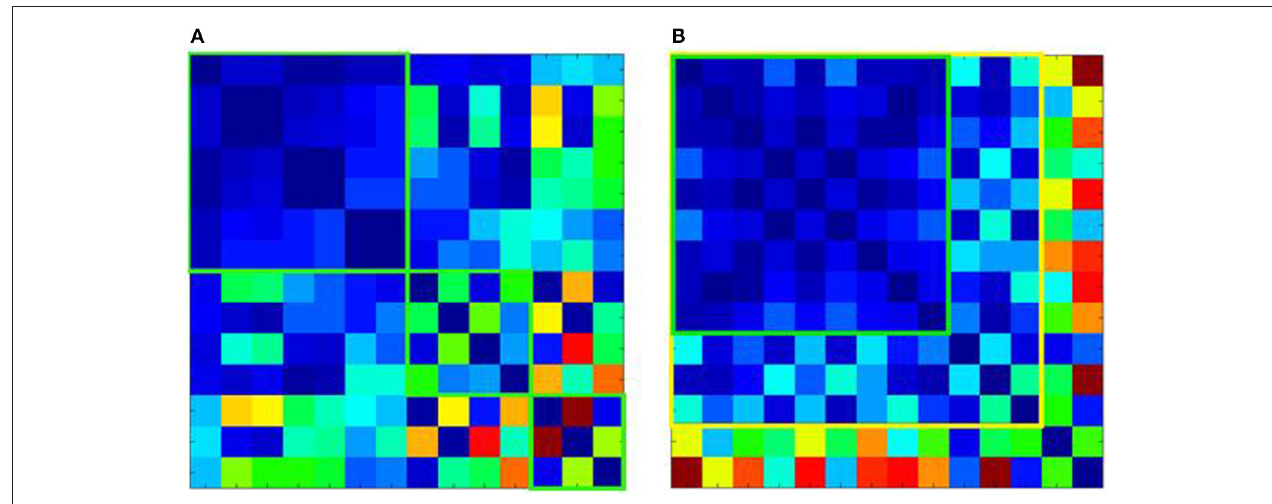
FIGURE 2 | Mahalanobis distance analysis of quality parameters for T1-weighted images of 14 ALS centers. (A) Shows the Mahalanobis distances of the raw T1 data, revealing 3 clusters of centers, which although internally homogenous (green squares) could not be pooled into one large data set. (B) Shows the effect of preprocessing. This allows pooling of T1 data from additional centers with good (green square) or acceptable homogeneity (yellow square). However, 2 centers although homogenous with each other, could not be pooled with the other data sets (shown in the last 2 rows or right-most columns,